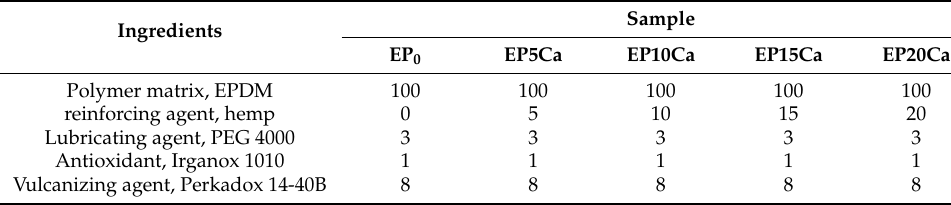
Table 1. Composite formulations a